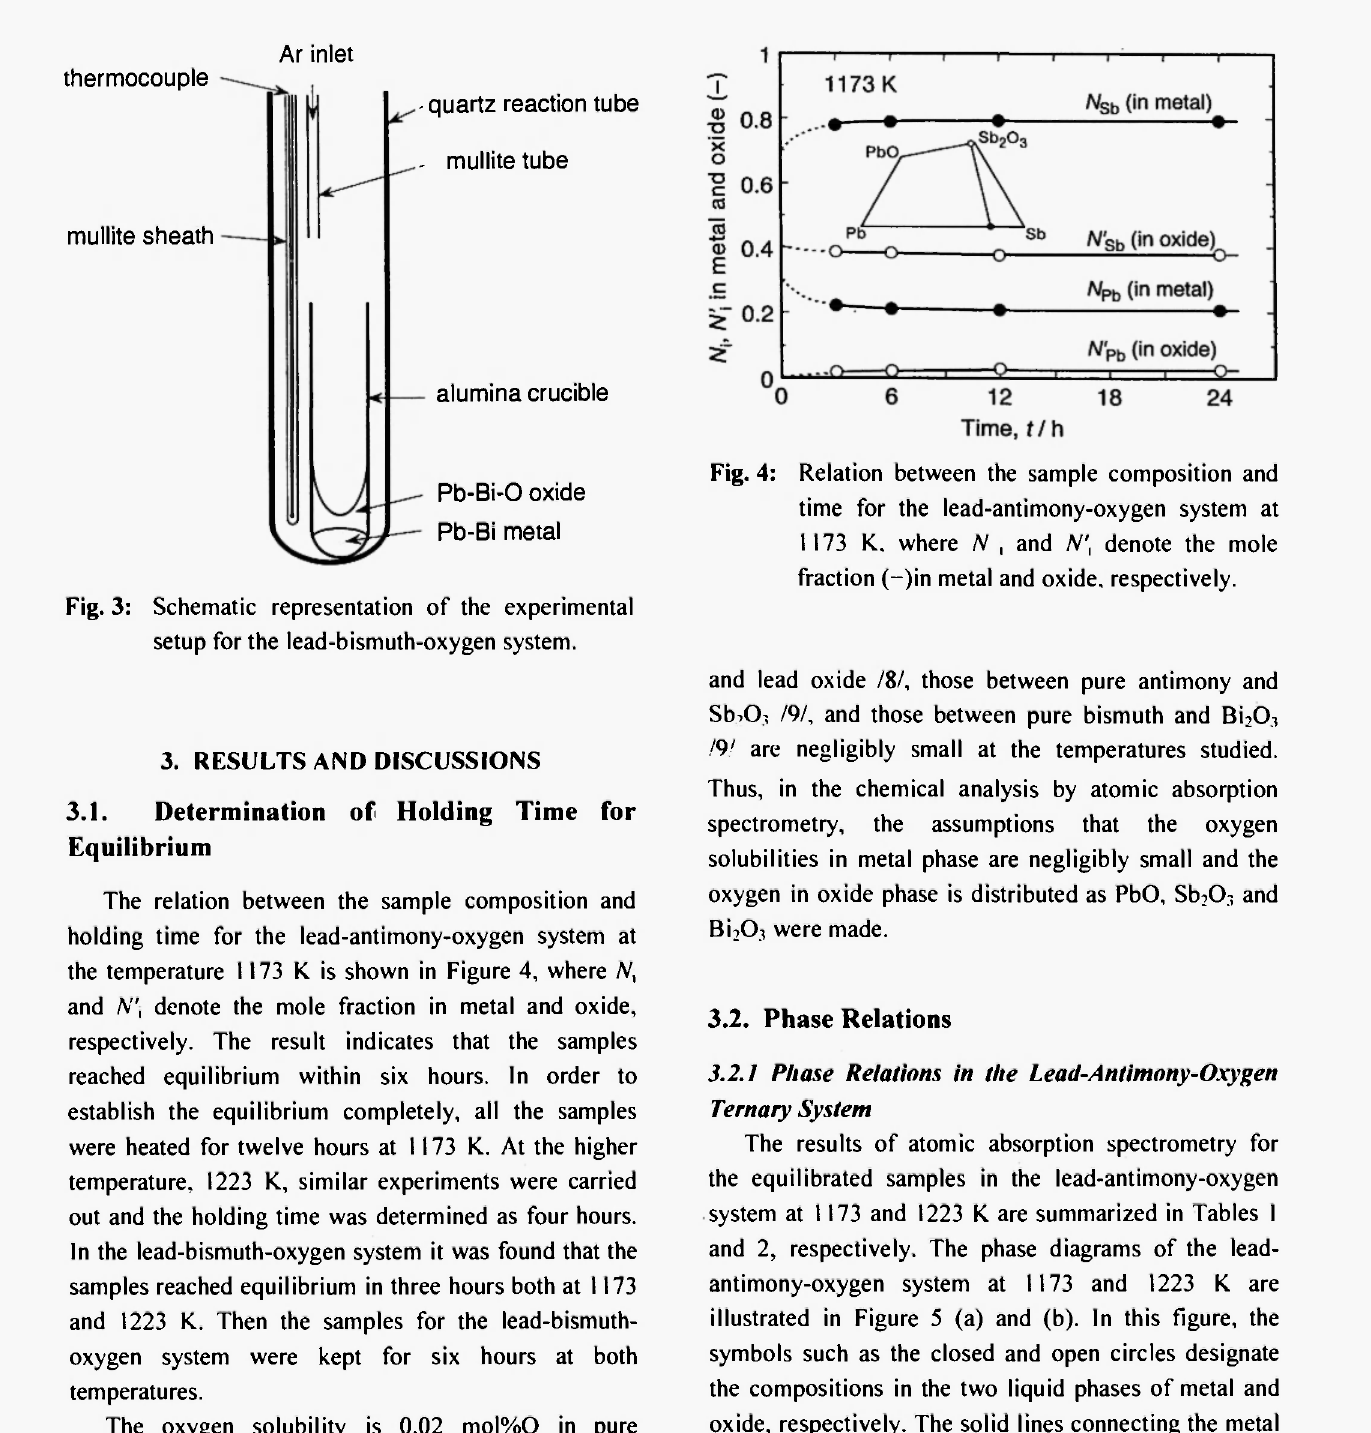
Fig. 4: Relation between the sample composition and time for the lead-antimony-oxygen system at 1173 K, where Ν , and N', denote the mole fraction (-)in metal and oxide,